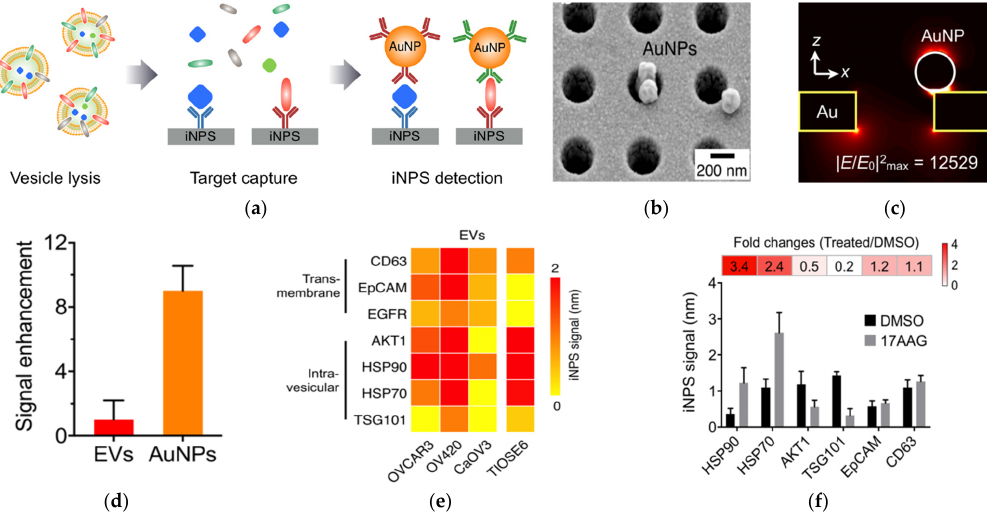
Figure 2. AuNP − amplified iNPS assay for the detection of intravesicular and transmembrane proteins. ( a ) Schematic of the methodology for EV protein detection. EVs are lysed to release proteins. Targeted proteins are captured on the iNPS chip via affinity ligands and detected by antibodies on AuNPs. ( b ) Scanning electron microscope image showing AuNPs on the iNPS sensor. ( c ) Finite difference time − domain (FDTD) simulation showing the concentration of the electrical fields on AuNPs. ( d ) Comparison of the signals with and without AuNPs on the iNPS sensor. ( e ) Protein profiling of EVs derived from ovarian cells. ( f ) Drug (HSP90 inhibitor) response monitoring of OV90 cells by EV protein detection with iNPS. The fold change is the protein level changes monitored by the iNPS spectral shifts after drug treatment. Reprinted with permission from [62]. Copyright (2018) American Chemical Society.